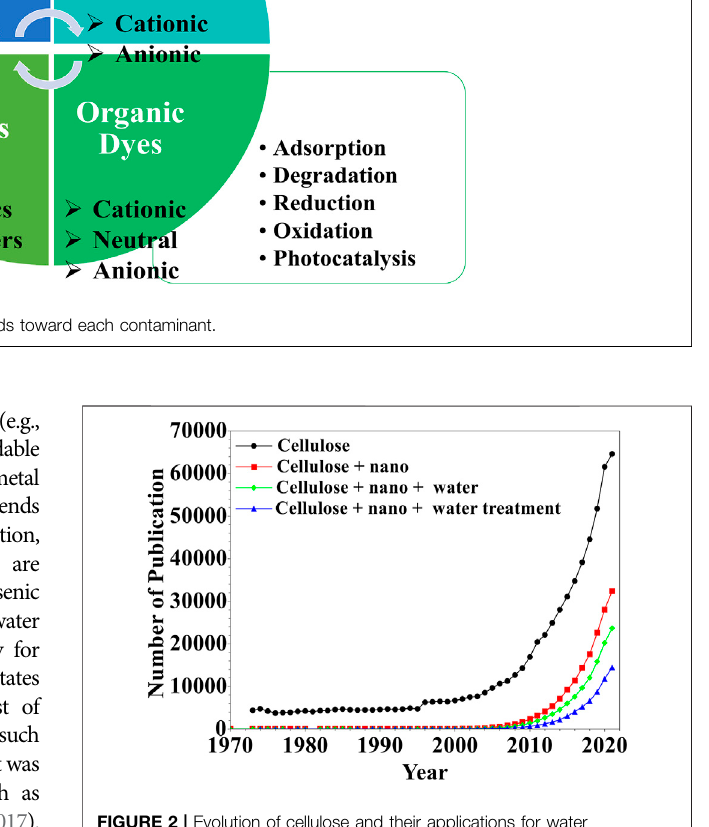
FIGURE 2 | Evolution of cellulose and their applications for water treatmentusing searching words of “ Cellulose ” , “ Cellulose+nano ” , “ Cellulose + nano + water ” , “ Cellulose + nano + water treatment ” . Data extracted from SCOPUS, Nov.